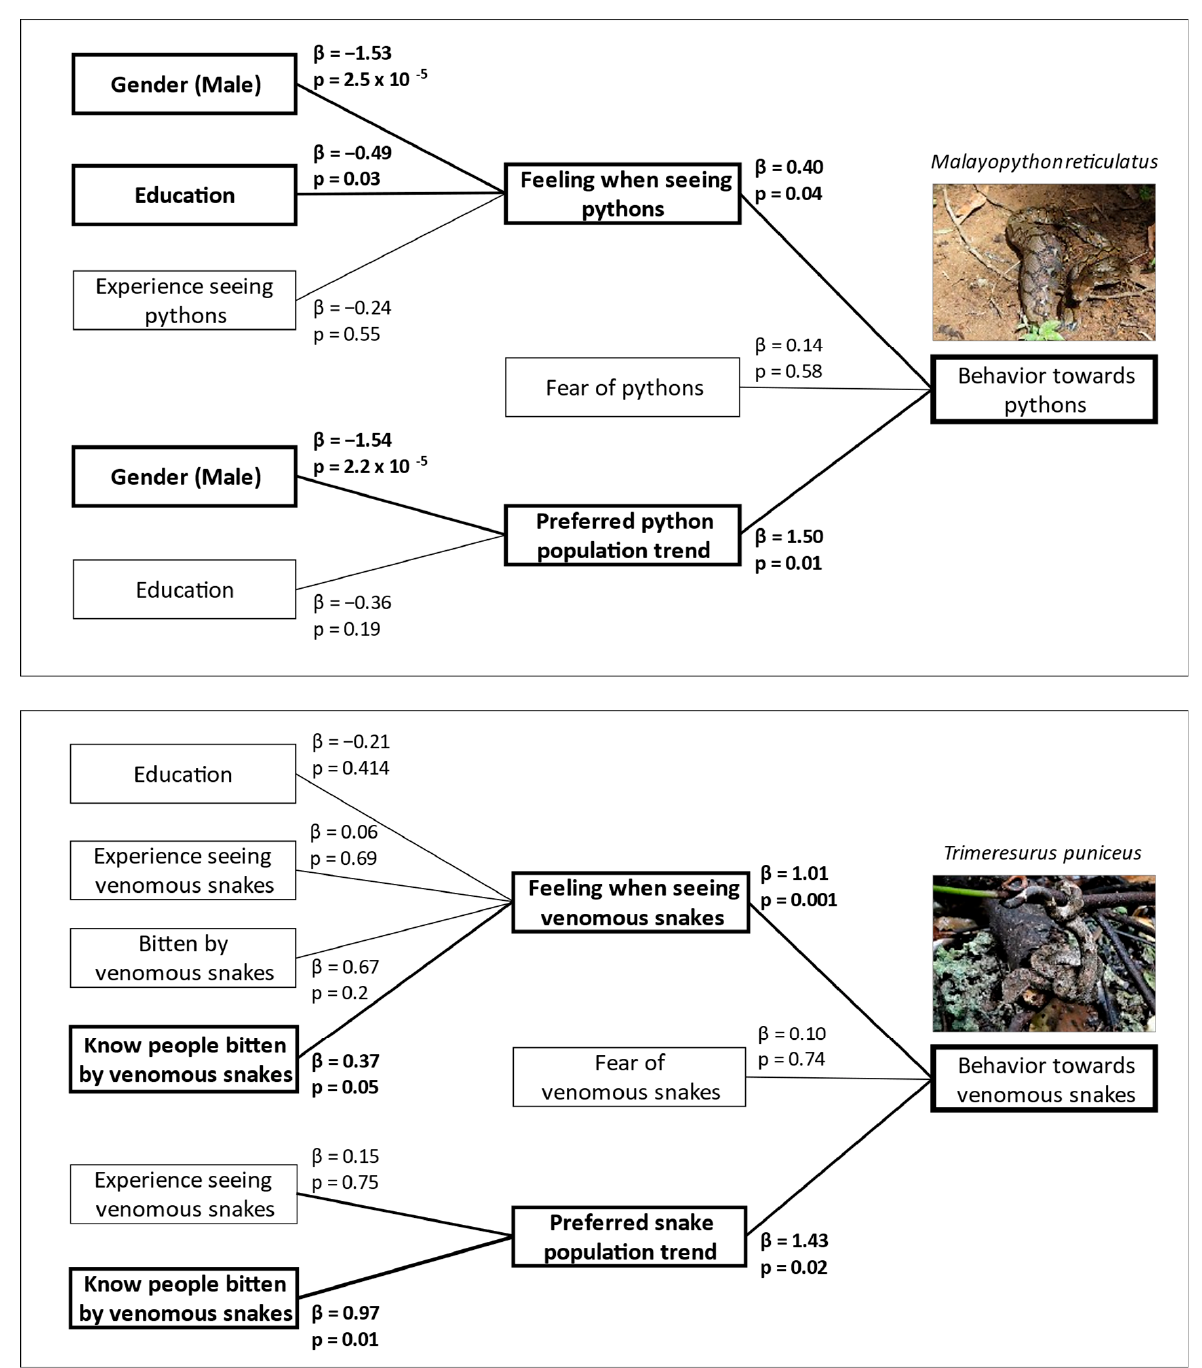
Figure 2. Cumulative link model diagram describing the explanatory variables of attitudes and behavior towards snakes based on model averaging of the top models with ∆ AICc < 2. Variables listed in the left column were represented in the top performing models based on the initial model building process, which were then averaged to identify significant predictors for attitudes toward snakes. Attitudes, including “feeling when seeing snakes”, “fear of snakes”, and “preferred snake population trend”, were then used as covariates to evaluate potential models predicting behavior toward both pythons and venomous snakes. Model-averaged coefficients ( β ) represent the strength and direction of the predictors, with positive coefficients indicating more negative attitudes/behavior (e.g., hate seeing snakes/prefer snake populations to decrease/try to kill snakes). Significant predic- tors ( p < 0.05) are highlighted in